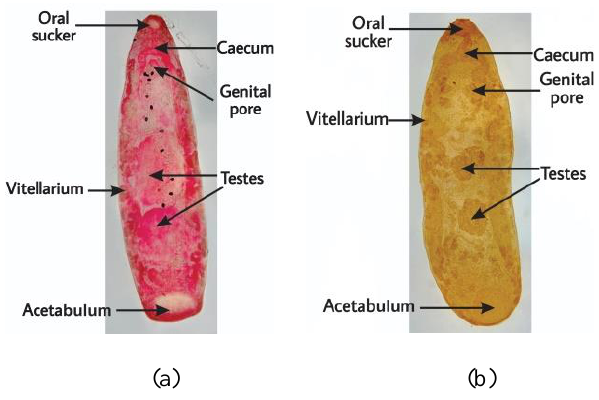
Fig. 2. Morphological identification of whole mount of Paramphistomum sp . : (a) Red Beet staining; (b) Acetocarmine staining